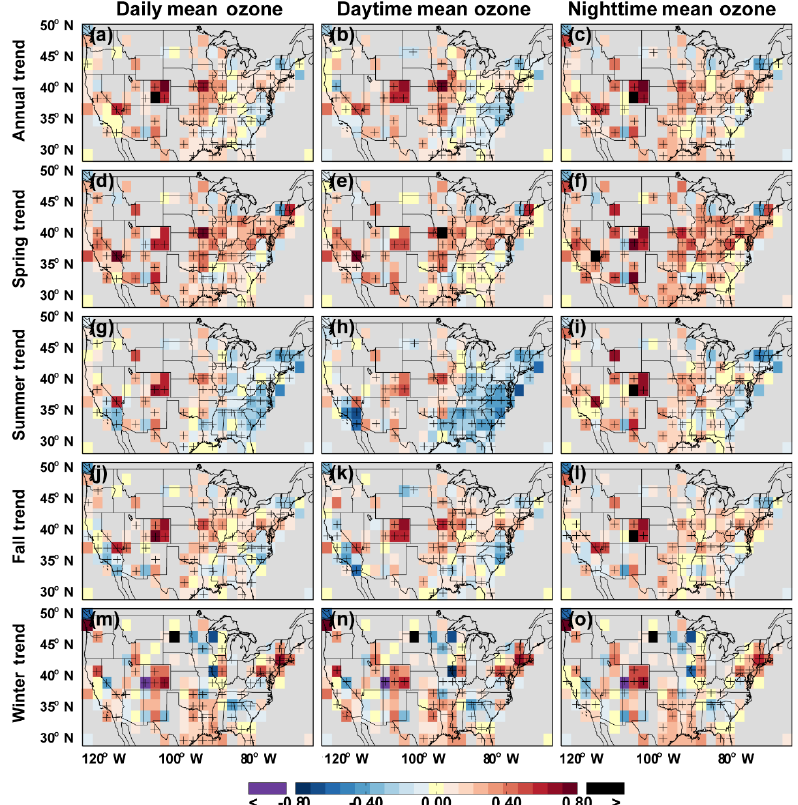
Figure 5. Trends over 1990–2014 in annual and seasonal daily mean, daytime mean, and nighttime mean ozone observations in the selected 124 grid cells. Trends are statistically significant ( P value<0.05 after a F test) in grid cells overlaid with “ + ”. The grid cells in grey have no data.